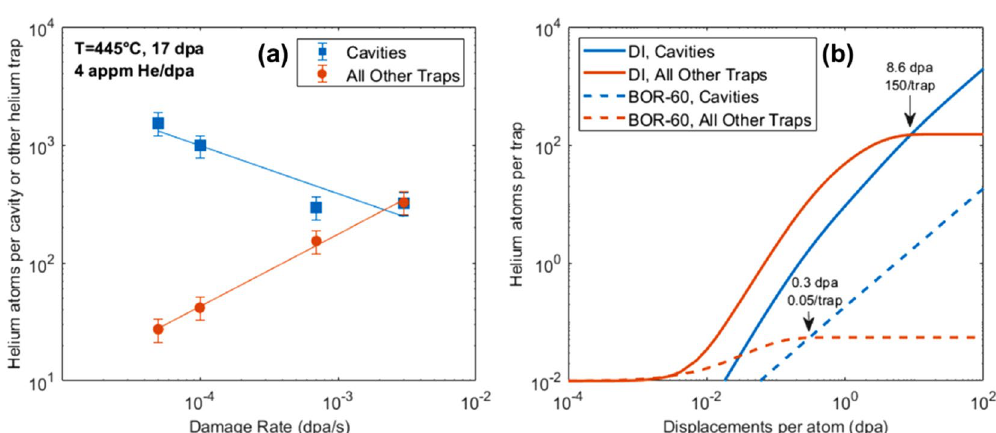
Figure 5. Helium content at cavities and all other traps (dislocation lines, dislocation loops, and HeV clusters) resulting from the trapping/de-trapping process in T91 for ( a ) dual ion irradiation to 17 dpa at 445 °C as a function of damage rate, and ( b ) BOR-60 irradiation at 376 °C with 0.22 appm He/dpa and dual ion irradiation at 445 °C with 4 appm He/dpa as a function of accumulated damage